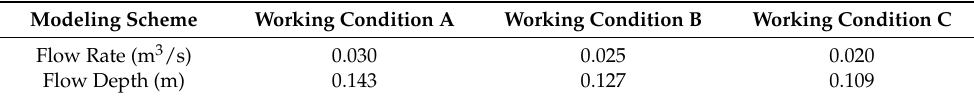
Table 1. Working conditions for the calculation.